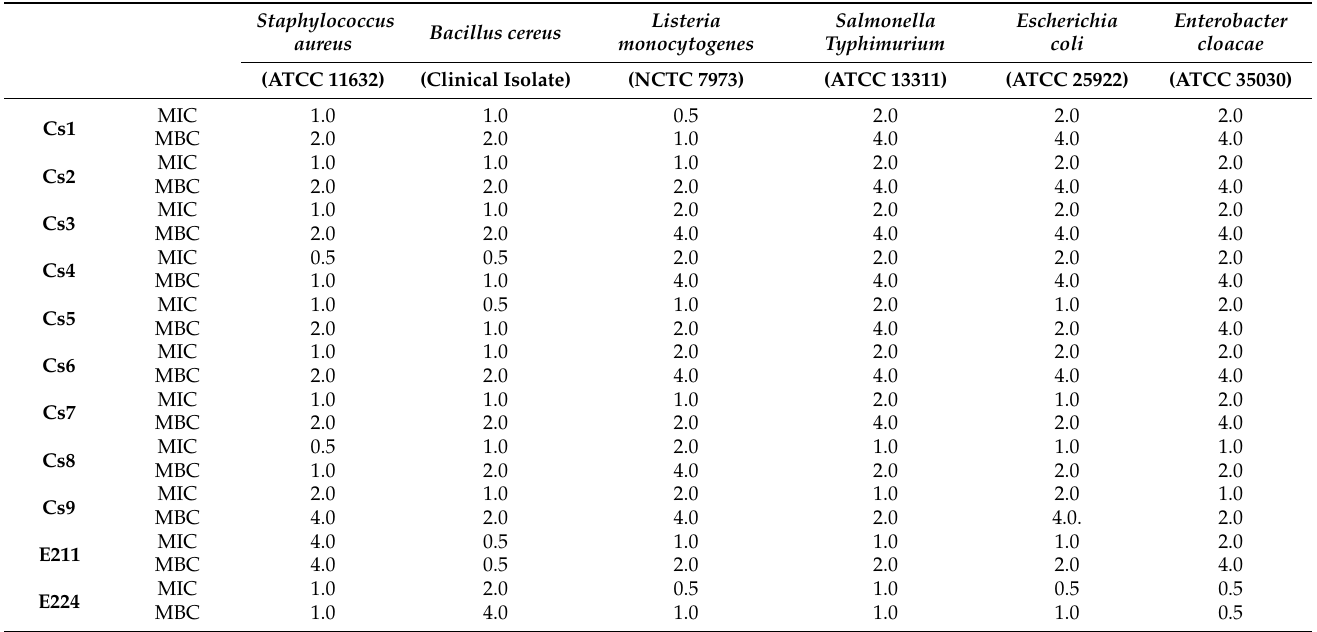
Table 4. Antibacterial activity of C. spicatum extracts mg/mL. For positive controls, E211—sodium benzoate and E244—potassium metabisulfite were